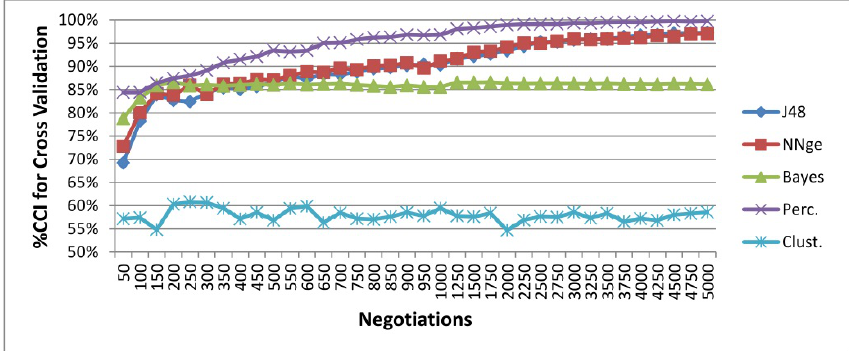
Figure 3. Protocol outcome prediction leveraging information from hidden mental states. The average accuracy is shown for 100 experiments with 5000 negotiations each. The learning algorithms considered include: a decision tree algorithm (J48), a rule induction method (NNge), a Bayesian network classifier (BayesNet), a feed-forward artificial neural network (multilayer perceptron), and a clustering-based classification